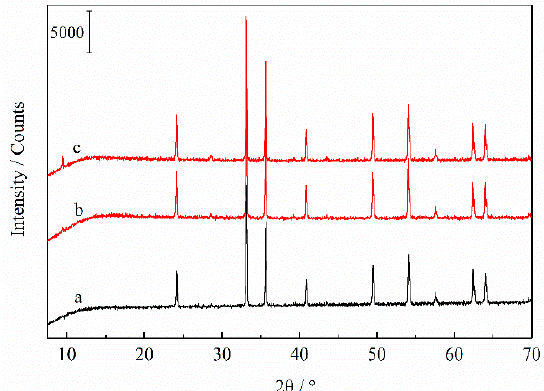
Figure 5. XRD patterns of the leaching residue of the roasted pyrite at different leaching times. ( a ) the roasted sample; ( b ) the leaching residue of the roasted sample with a leaching time of 1 h; ( c ) leaching residue of the roasted sample with a leaching time of 4 h.